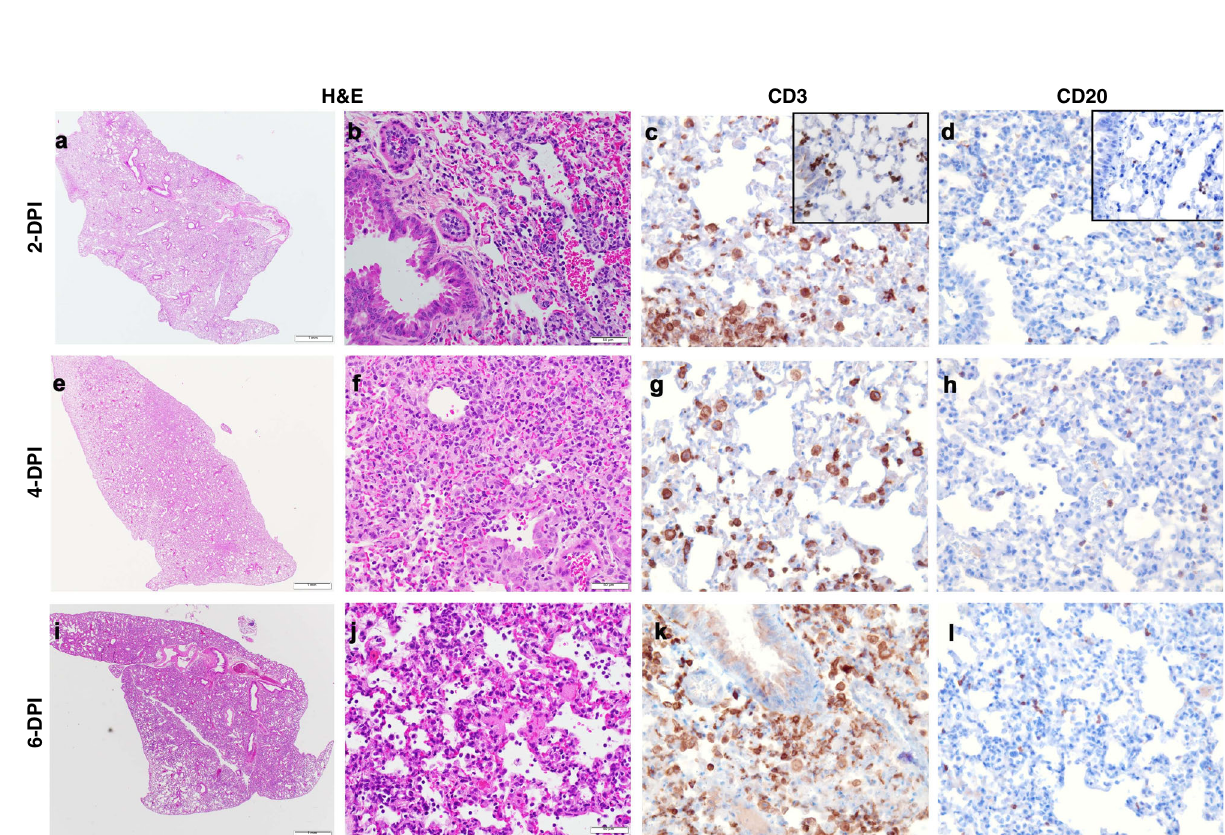
Fig. 6 T- and B-cell accumulation in lung of SARS-CoV-2-infected K18 hACE2 transgenic mice. Incremental in fl ammation was noted histologically at 2 ( a , b ), 4 ( e , f ), and 6 ( i , j ) DPI. There was signi fi cant CD3 cytoplasmic immunolabeling of interstitial round cells in the lung that were morphologically consistent with lymphocytes. Alveolar and interstitial macrophages in the lungs also had strong cytoplasmic immunolabeling with CD3. Evaluation of control tissues (inset) showed CD3 antibody clearly labeling other in fl ammatory cells that were morphologically not consistent with T cells c , g , k . Individual positive CD20 B cells were apparent in the interstitium of the lung alveolar septa. CD20 B cells were present in similar amounts in control (inset) SARS-CoV-2-infected tissues d , h , l . Representative images of n = 6 (50:50 male:female per time-point and group) randomly chosen. Scale bars left images, 1 mm. Scale bars right images, 50 μ m. Data are representative over two independent